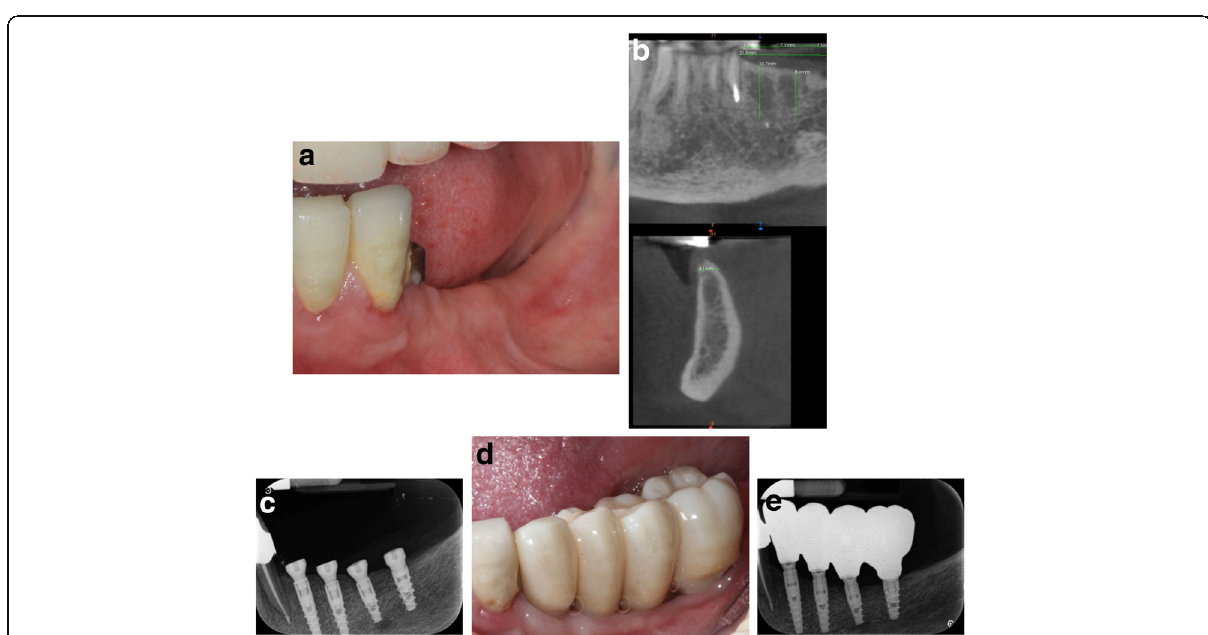
Fig. 3 Example of another case involved in the study. a Preoperative view – premolars and molars are missing in left mandible. b Preoperative CT scan. The width of the ridge was around 4 mm. c Baseline periapical radiograph. Four narrow diameter implants were placed to restore the area. d Buccal view of the final full-contour zirconia restoration. e Periapical radiograph at 1 year after